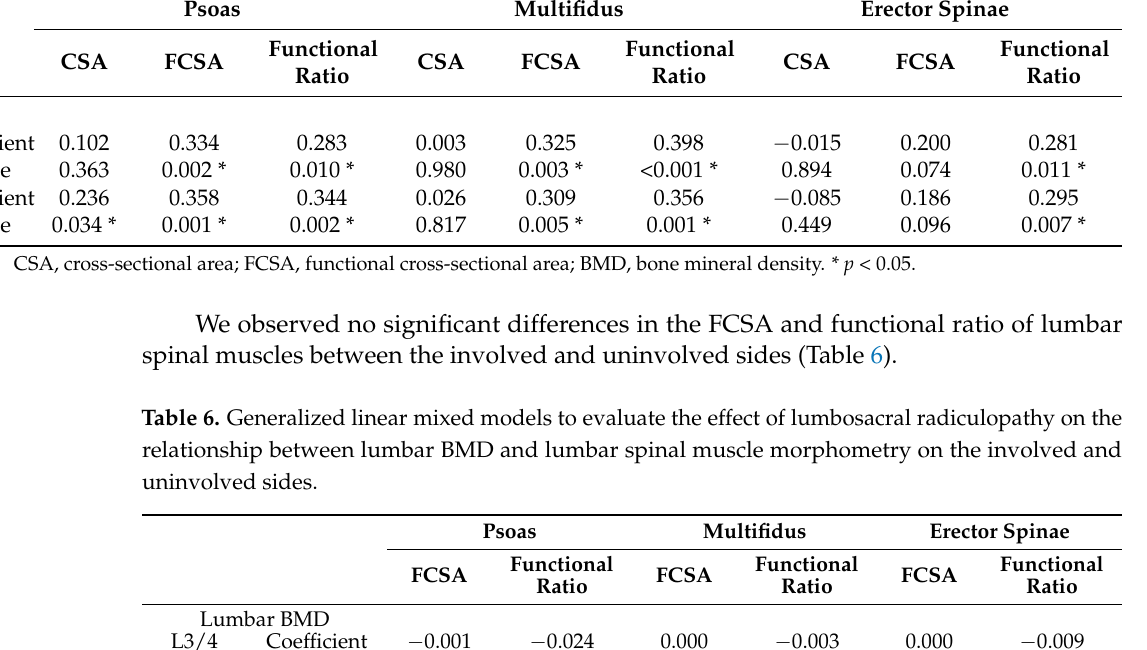
Table 5. Pearson correlation analysis to analyze the correlation between lumbar spinal muscular morphometry and lumbar BMD. Psoas Multifidus Erector Spinae Functional Functional Functional CSA FCSA CSA FCSA CSA FCSA Ratio Ratio Ratio Lumbar BMD L3/4 Coefficient 0.102 0.334 0.283 0.003 0.281 0.980 0.011 * L4/5 Coefficient 0.236 0.358 0.344 0.026 0.186 0.295